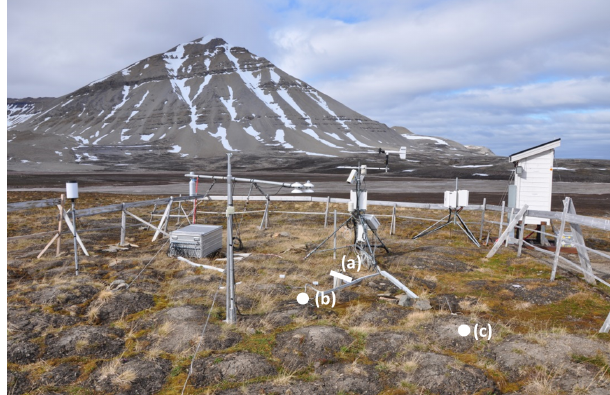
Figure C6. Location of soil profiles, Bayelva, 1998, 1999 and 2009, (78.92094 ◦ N, 11.83334 ◦ E). (a) The 2-D soil profile and station location 1998 (installed August 1998), (b) 1-D soil station 1999 (installed July 1999), and (c) 1-D soil profile and station 2009 (in- stalled August 2009).